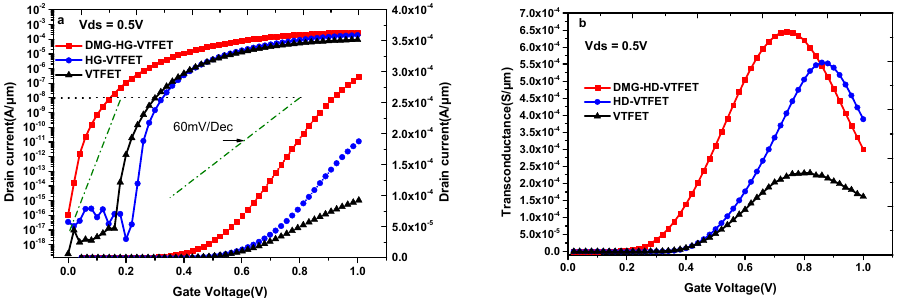
Figure 5. ( a ) The transfer characteristics of VTFET, HD-VTFET, and DMG-HD-VTFET; ( b ) transconductance of VTFET, HD-VTFET, and DMG-HD-VTFET.